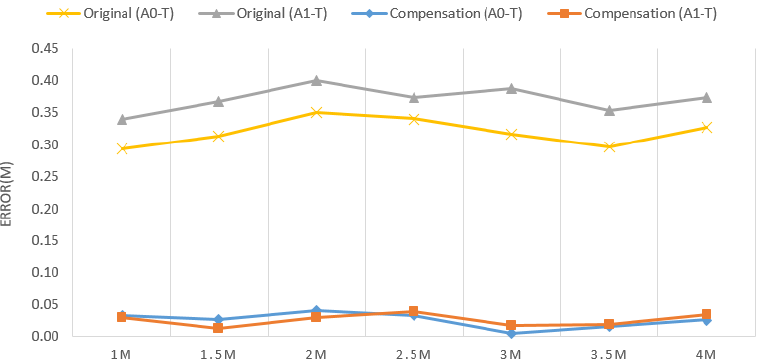
Figure 2. Distance errors before and after compensation.